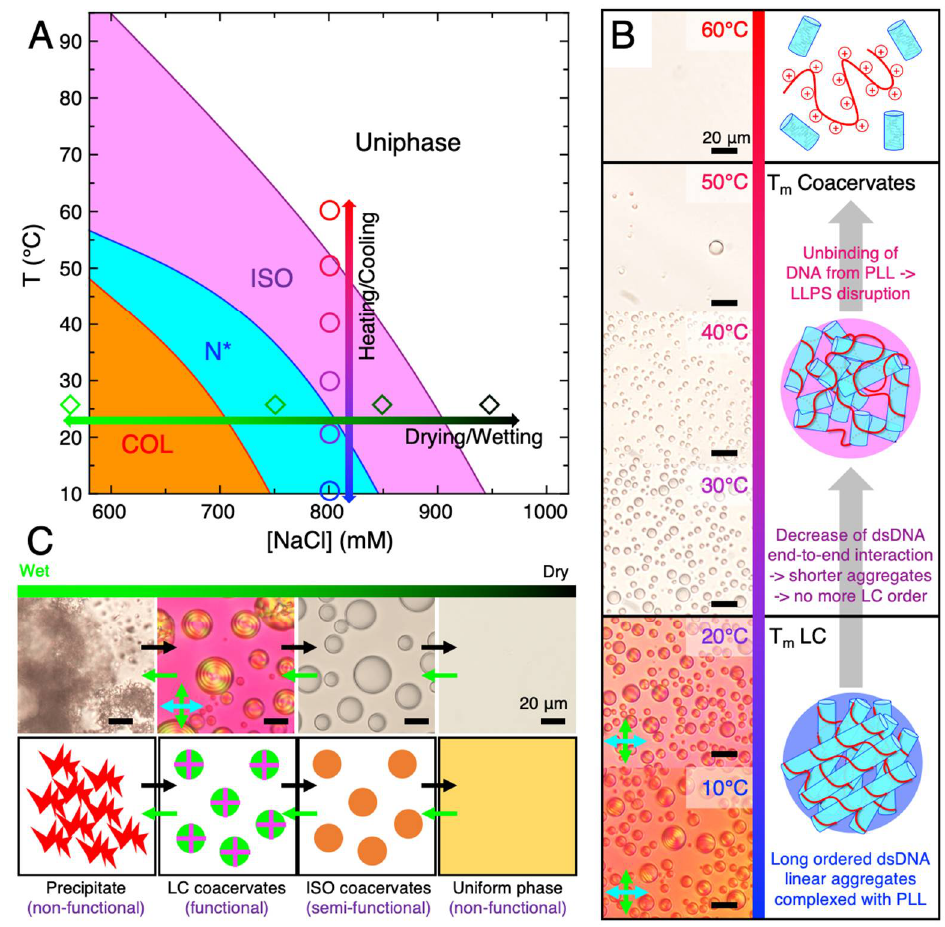
Figure 3. Stability of LC-coacervate phases in temperature and hydration cycles. ( A ) Phase diagram of the LC-coacervate system at different T and [NaCl]. Increasing temperature transitions the system between various mesophases such as from the columnar phases (COL), to N*, to ISO, and finally to a uniform phase. Modulation of the [NaCl] of a system, potentially through drying and wetting, also results in transition between the same phases. ( B ) PTOM and BFTOM images of the LC-coacervate system at various temperatures (corresponding to the color-coded empty circles in A), showing the transition between the mesophases upon heating. At low temperatures, the LC-coacervate phase exists due to the presence of enough long linear aggregates of s-dsDNA complexed with PLL (blue shaded sketch), while heating causes transition from LC to ISO coacervates as a consequence of the weakening of the s-dsDNA end-to-end interactions, resulting in less ordered and shorter s-dsDNA aggregates still complexed with PLL (magenta shaded sketch). Further heating results then in dissociation of the coacervate droplets and formation of the uniform phase, due to the unbinding of the DNA from the peptide. ( C ) PTOM and BFTOM images of dehydration of an rDD-PLL system at room temperature (corresponding to the color-coded empty diamonds in A). A continuous transition from precipitate, to LC-coacervate droplets, to ISO coacervate droplets, to a uniform phase occurred over the drying process, mainly due to the effect of the increasing [NaCl]. In this way, environmental dehydration and rehydration could result in continuous transitions between functional LC-coacervate or semi-functional isotropic coacervate states and non-functional precipitate or uniform phase states (sketches). Scale bars 20 µm.